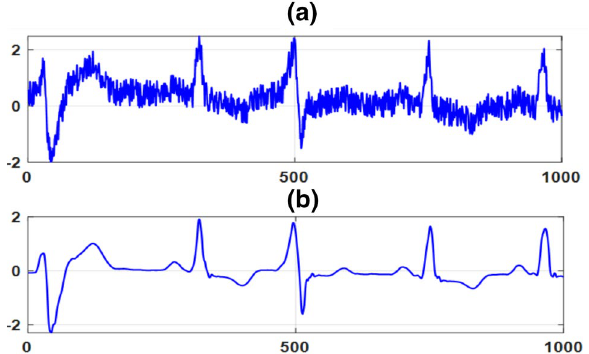
Figure 4. ( a ) ECG signal with the baseline drift and high frequency noise. ( b ) The baseline drift and high frequency noise free signal after DWT based